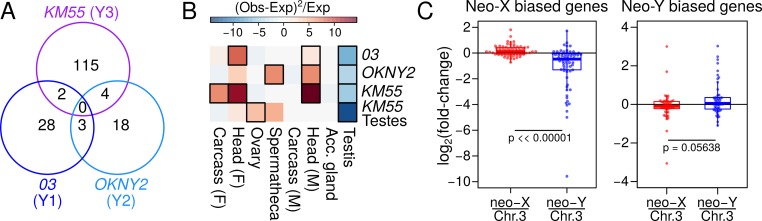
Independent gene-by-gene downregulation of neo-Y alleles.A. Venn diagram illustrates the number of neo-X biased genes that overlap between the neo-Y haplotypes. B. The heatmap depicts over- and under-representation of tissue-bias among neo-X-biased genes among the different neo-Ys. Colors represents the Chi-square statistics, modified to include enrichment (+) or depletion (–); significant cells are boxed with black borders (p < 0.05, see materials and methods). To expand the number of genes for this analysis, we used a less stringent cutoff (p-value < 0.1) than the one used in Table 2. C. For genes with neo-sex bias in strain D.alb.03, we determined their allele-specific expression in reciprocal hybrid males with Chr. 3 and either neo-X or neo-Y. The distribution (boxplot) and the gene-by-gene (points) fold-difference of the alleles are plotted in log scale for the neo-X biased genes (left) and neo-Y biased genes (right). For the neo-X biased genes, neo-X and Chr. 3 alleles have similar expression level, but the neo-Y allele is on average lower than the Chr. 3 allele. For the neo-Y biased genes, both the neo-X and neo-Y alleles are similar to the Chr. 3 alleles. P-values are based on Wilcoxon rank sum test.